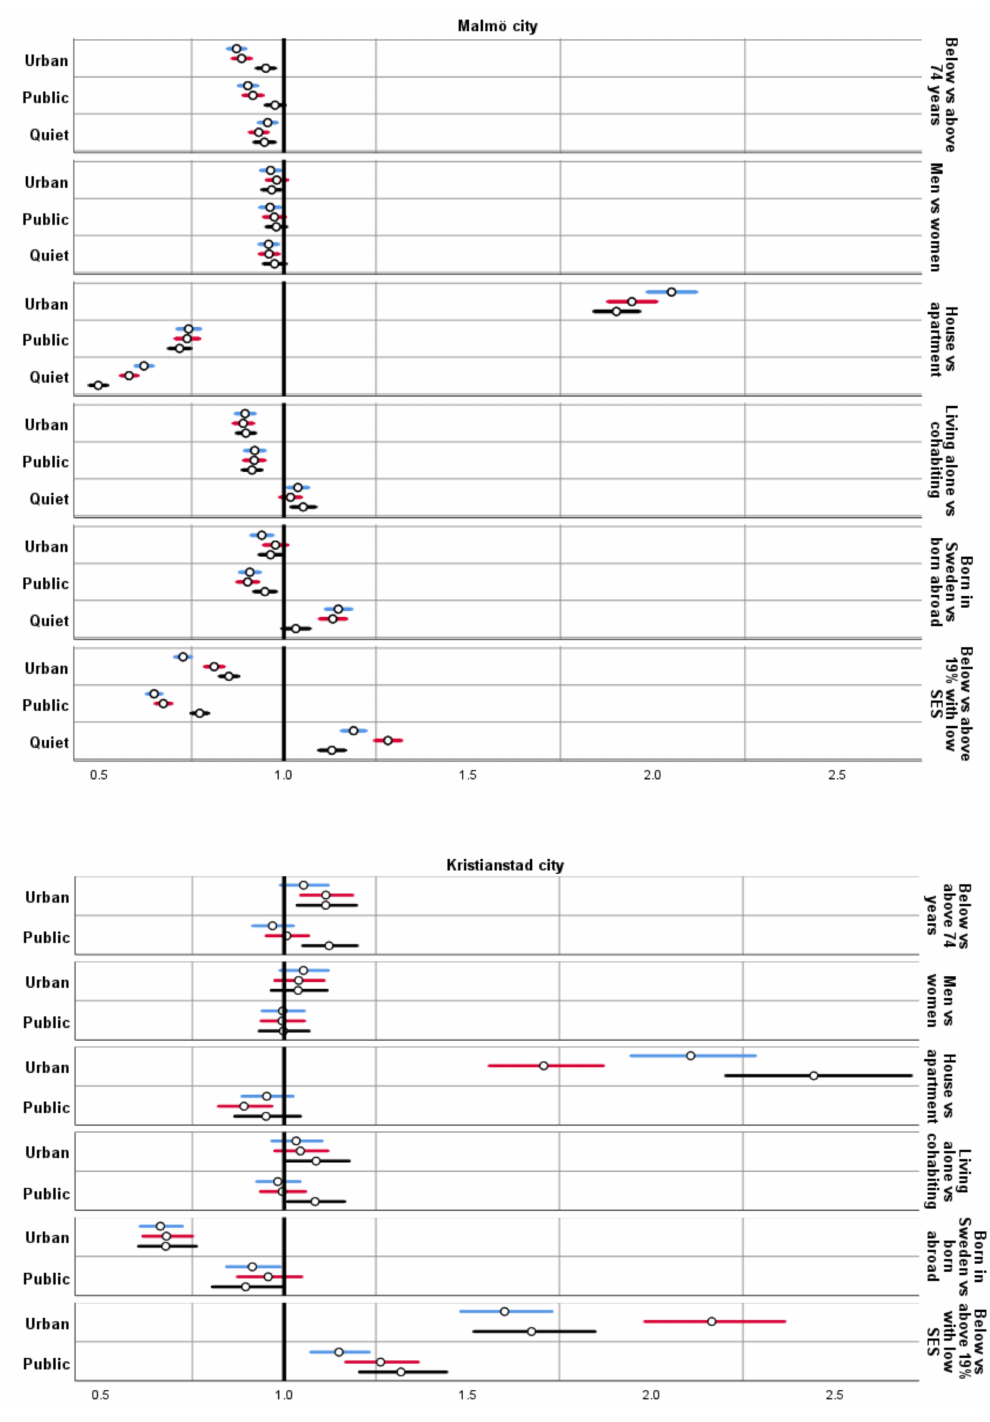
Figure 4. Adjusted risk ratios (dots) with 95% confidence intervals (lines; blue = 2019, red = 2015, black = 2010) for associations between sociodemographic variables and different measures of urban green spaces within 300 m of residency in Malmö city (top) and Kristianstad city